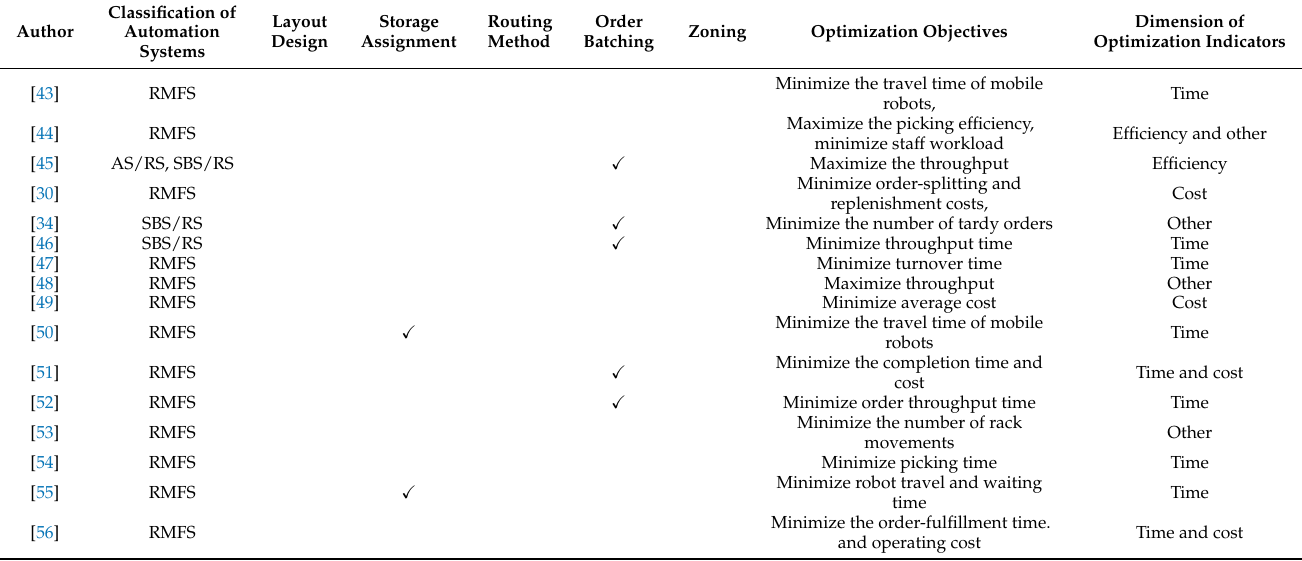
Table 5. Summary of literature related to the “parts-to-picker” picking